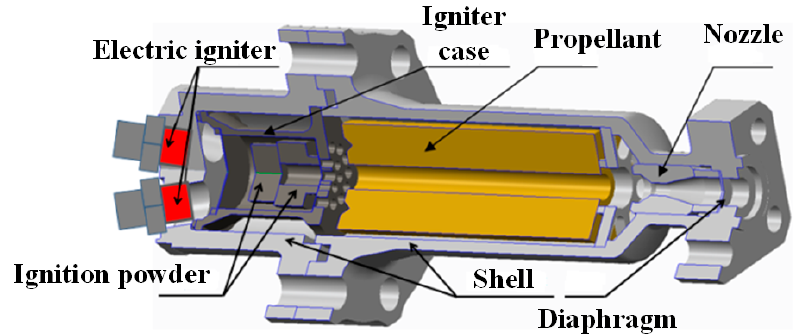
Figure 1. Cross section of a pyrotechnic igniter.